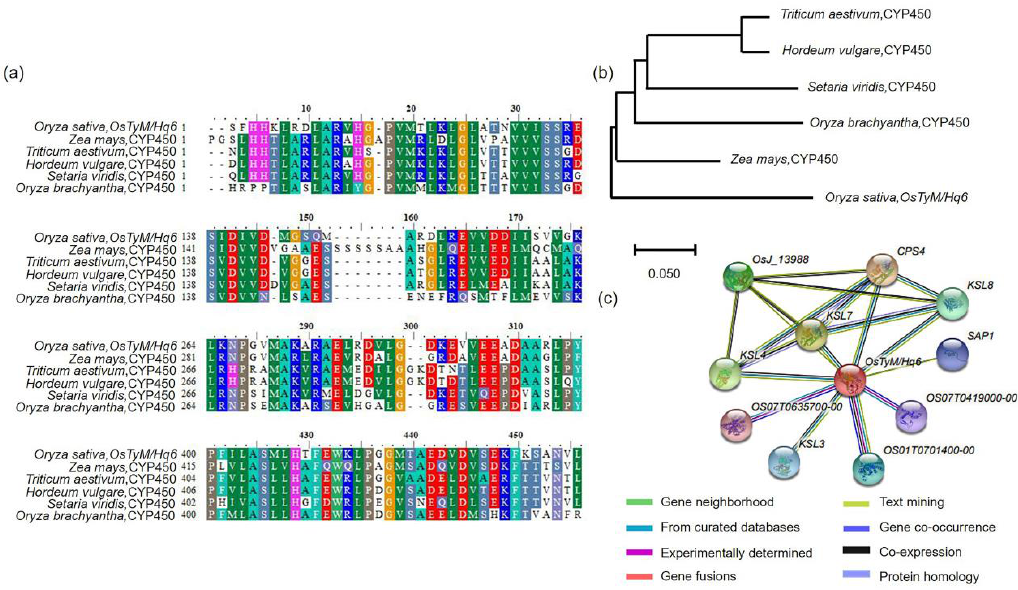
Figure 6. Sequence analysis of OsTyM/Hq6 . ( a ) Comparison of the protein sequences of OsTyM/Hq6 homologous genes; substantially high similarity was found in Zea mays , Hordeum vulgare , Setaria viridis , Triticum aestivum , and Oryza brachyantha . ( b ) The phylogenetic tree was used to analyze OsTyM/Hq6 and its homologous genes. The phylogenetic tree was constructed with 1000 bootstrap replicates using the parsimony method. ( c ) Protein interaction of OsTyM/Hq6 . The gene interacts with OsJ_13988, CPS4, KSL4, KSL7, OS07T0635700-00, SAP1, OS07T0419000-00, KSL3, and OS01T0701400-00.